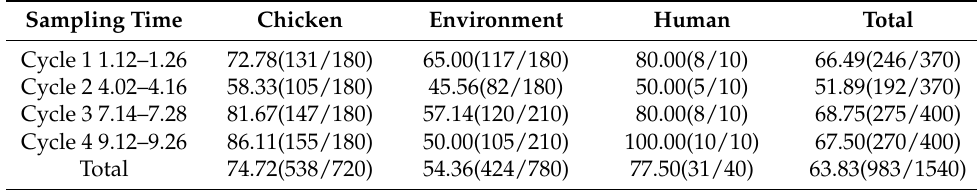
Table 1. Isolation rate of E. coli in four breeding cycles (unit: %). Sampling